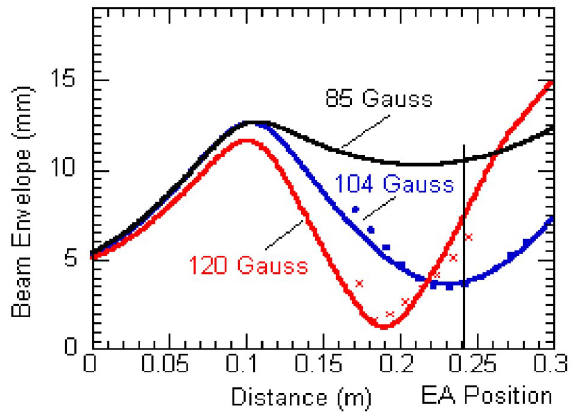
FIG. 5. (Color) Beam envelope from the electron gun to the energy analyzer for three different focusing strengths of the solenoid.